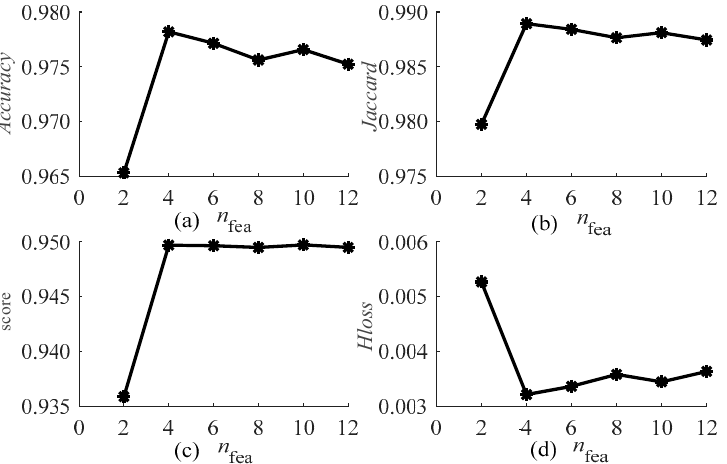
Figure 6. Evaluation results of ML-RF with different number of features selected as candidates at each split ( n fea ). ( a ) Accuracy Score; ( b ) Jaccard Similarity; ( c ) F1 Score; ( d ) Hamming Loss.